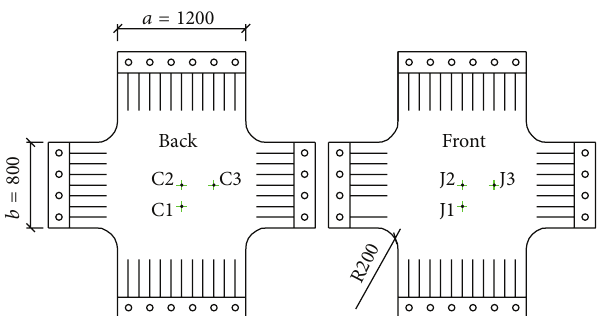
Table 3: The material parameters of the Xing Yida membrane.